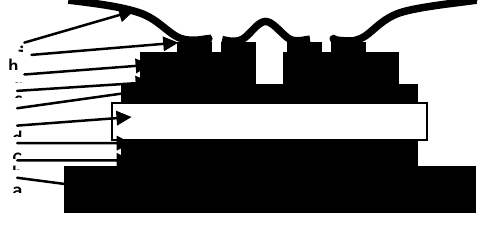
Fig. 1. IGBT module